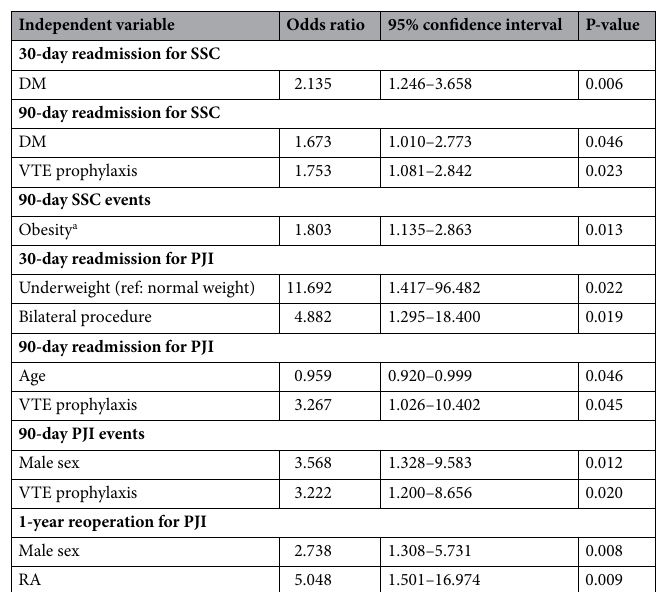
Table 3. Risk factors for postoperative infection events. DM: diabetes mellitus; PJI: periprosthetic joint infection; SSI: surgical site infection; VTE: venous thromboembolism. a Including obesity class I, II and III.